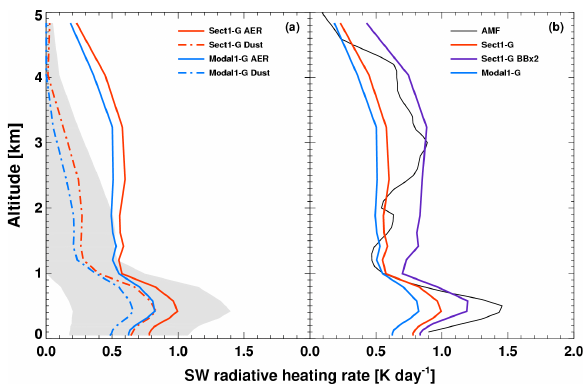
Figure 11 (a) SW aerosol (solid line) and dust (dot dash line) heating profiles from the 8 Fig. 11. (a) SW aerosol (solid line) and dust (dot dash line) heat- WRF-Chem simulations in different cases at 8-12 UTC for the DABEX period at the 9 ing profiles from the WRF-Chem simulations in different cases at 08:00–12:00UTC for the DABEX period at the Niamey airport. Niamey airport. The gray area represents the variation of Sect1-G simulated SW dust 10 The gray area represents the variation of Sect1-G simulated SW dust heating rate due to the uncertainty of n i (imaginary part of refrac- heating rate due to the uncertainty of n i (imaginary part of refractive index) of mineral 11 tive index) of mineral dust; (b) SW aerosol heating profiles from dust; (b) SW aerosol heating profiles from the calculations based on the AMF retrievals 12 the calculations based on the AMF retrievals and the WRF-Chem simulations in different cases at 08:00–12:00UTC for the DABEX and the WRF-Chem simulations in different cases at 8-12 UTC for the DABEX period at 13 period at the Niamey airport. the Niamey airport. 14 15